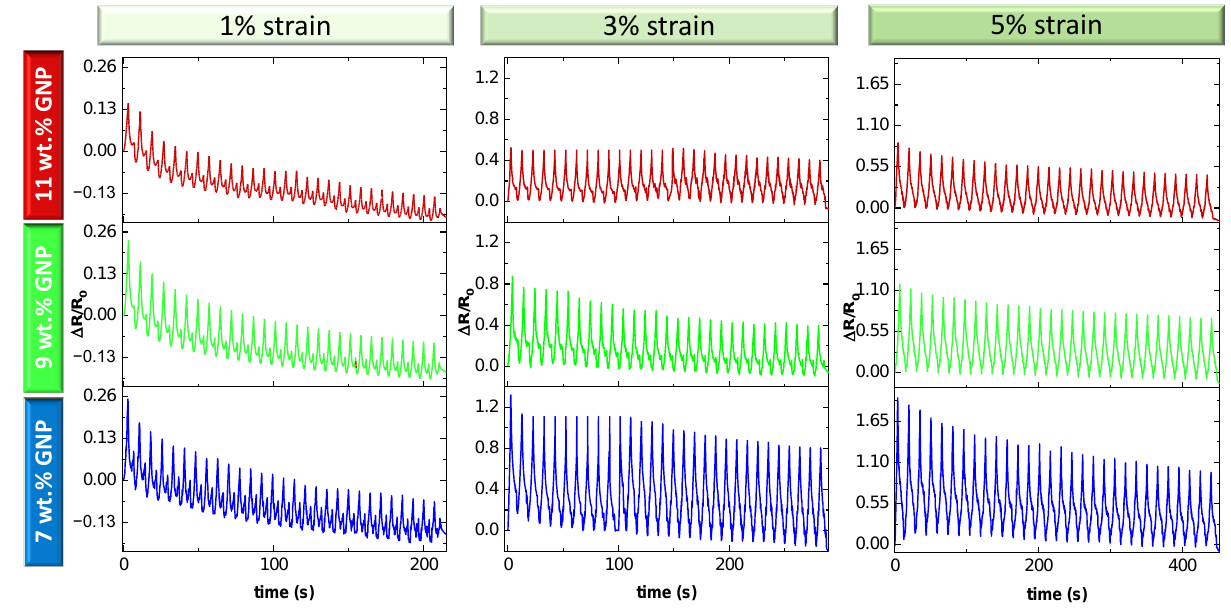
Figure 4. Electromechanical response under cycling load for the different GNP-PDMS sensors at three strain levels (1, 3 and 5%).